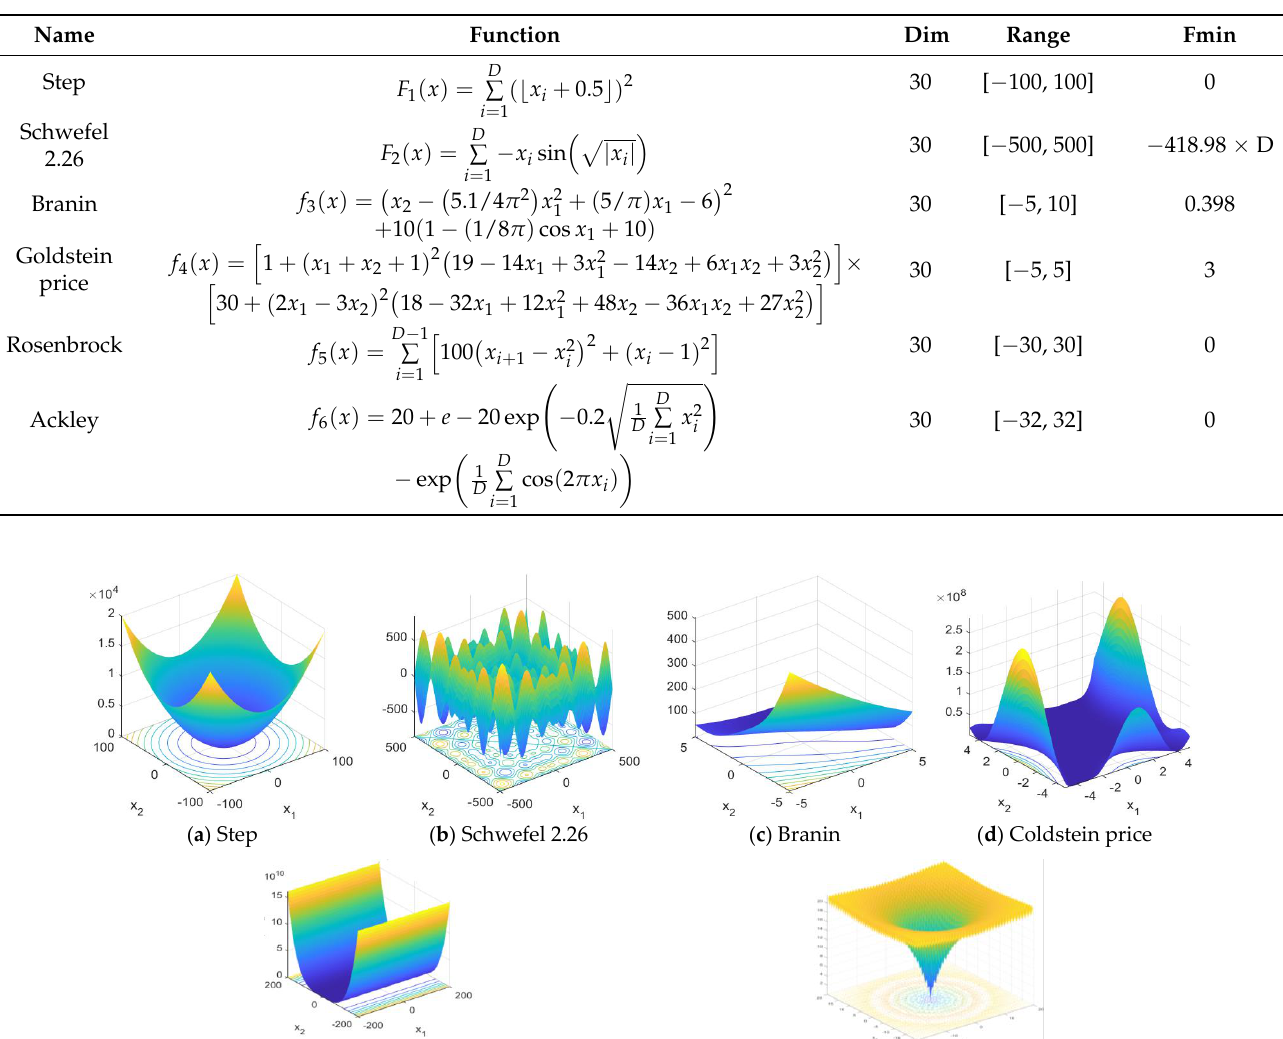
Table 5. Benchmark functions.